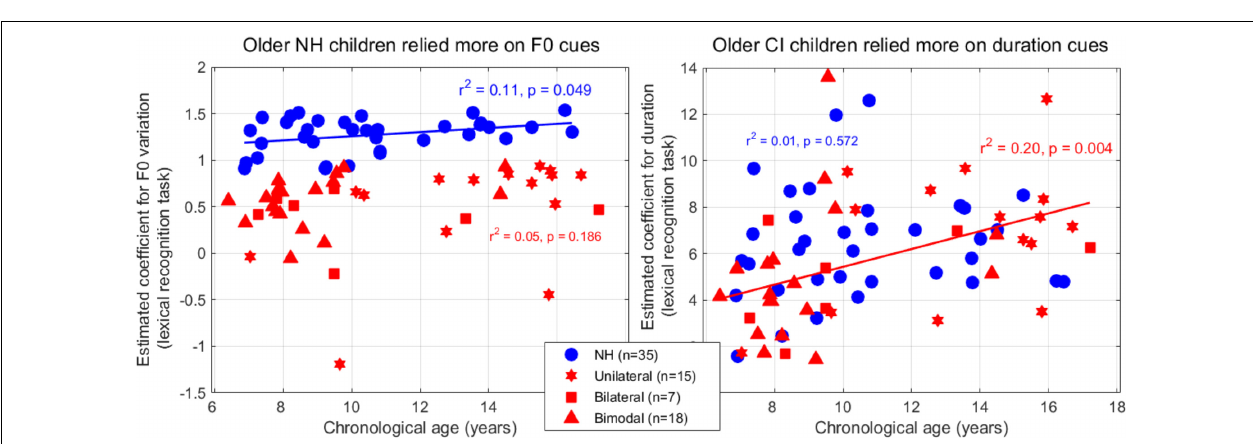
FIGURE 9 | Coefficients extracted from the logistic mixed-effect model reflecting the reliance on F0-variation (left) and duration (right) in the lexical tone recognition task, as a function of the children’s age.